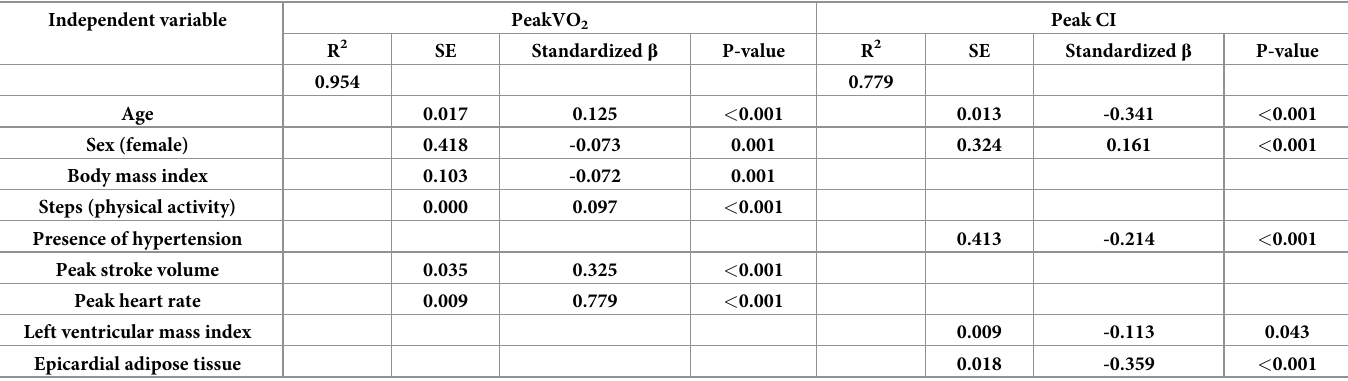
Table 4. Multiple linear regression analysis with peakVO 2 and peak CI as dependent